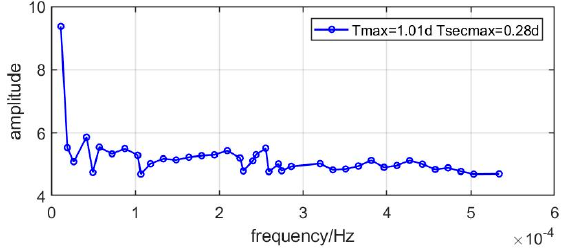
Figure 4. Spectrum analysis results of RDSS time service error. Figure 4. spectrum analysis results of RDSS time service error. Figure 4. spectrum analysis results of RDSS time service error.